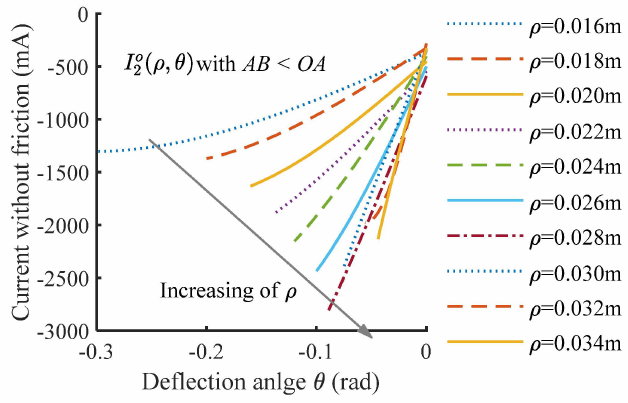
Figure 20. Frictionless current estimation for cam C 2 in configuration